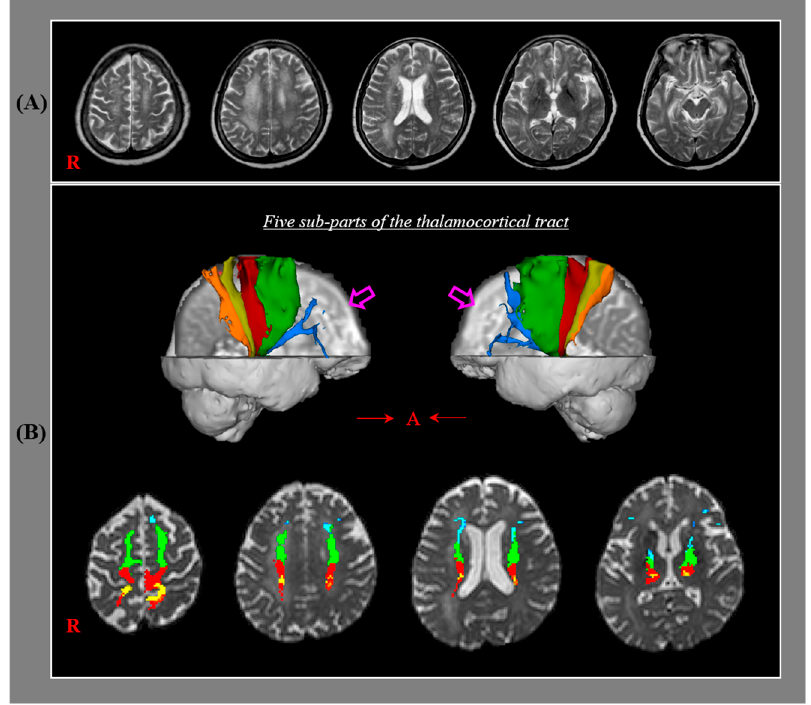
Figure 1. ( A ) T2-weighted brain magnetic resonance images in a representative subject (58-year-old female). ( B ) Results of diffusion tensor tractography (DTT) for the five subparts of the thalamocortical tract of the ascending reticular activating system: the prefrontal part of the thalamocortical tract (blue color), the premotor part of the thalamocortical tract (green color), the primary motor part of the thalamocortical tract (red color), the primary somatosensory part of the thalamocortical tract (yellow color), and the posterior parietal part of the thalamocortical tract (orange color). The prefrontal part is decreased compared to the other parts (arrow). R: right, A: anterior.